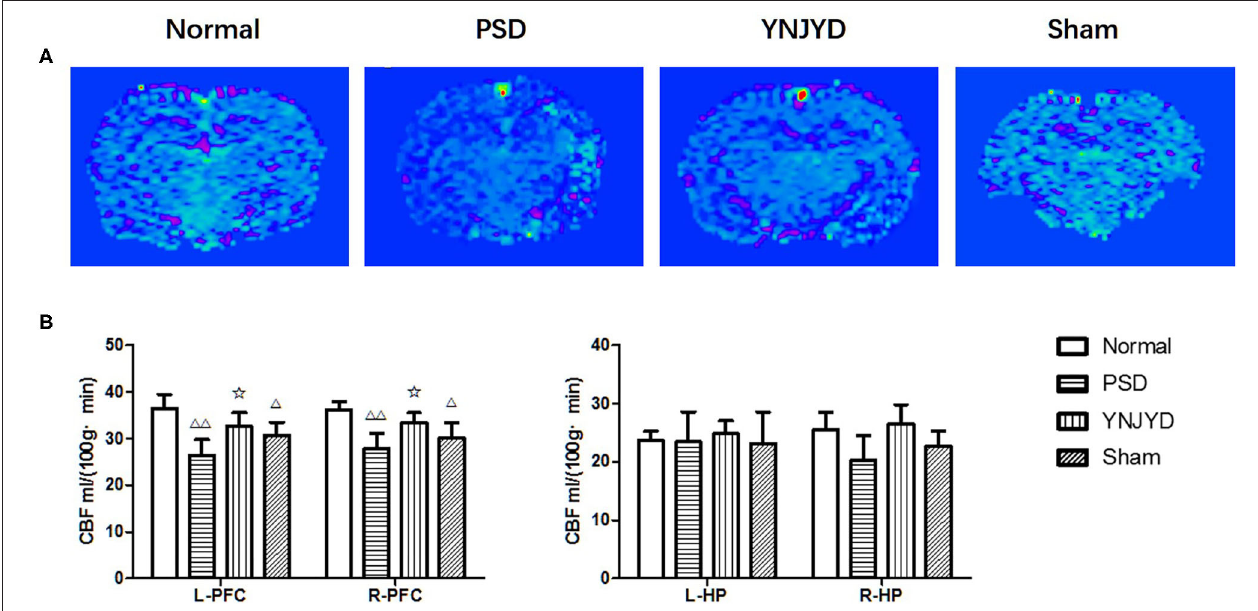
FIGURE 7 | Effects of yi-nao-jie-yu (YNJYD) administration on changes in cerebral blood flow (CBF) detected by arterial spin labeling (ASL) in normal, post-stroke depression (PSD), YNJYD-treated, and sham-operated rats. (A) ASL magnetic resonance (MR) images of the four groups. (B) Analysis of CBF in the left (L) and right (R) prefrontal cortex (PFC) and hippocampus (HP). The data are presented as means ± SD. 1 P < 0.05, 11 P < 0.01 vs. normal; 9 P < 0.05.